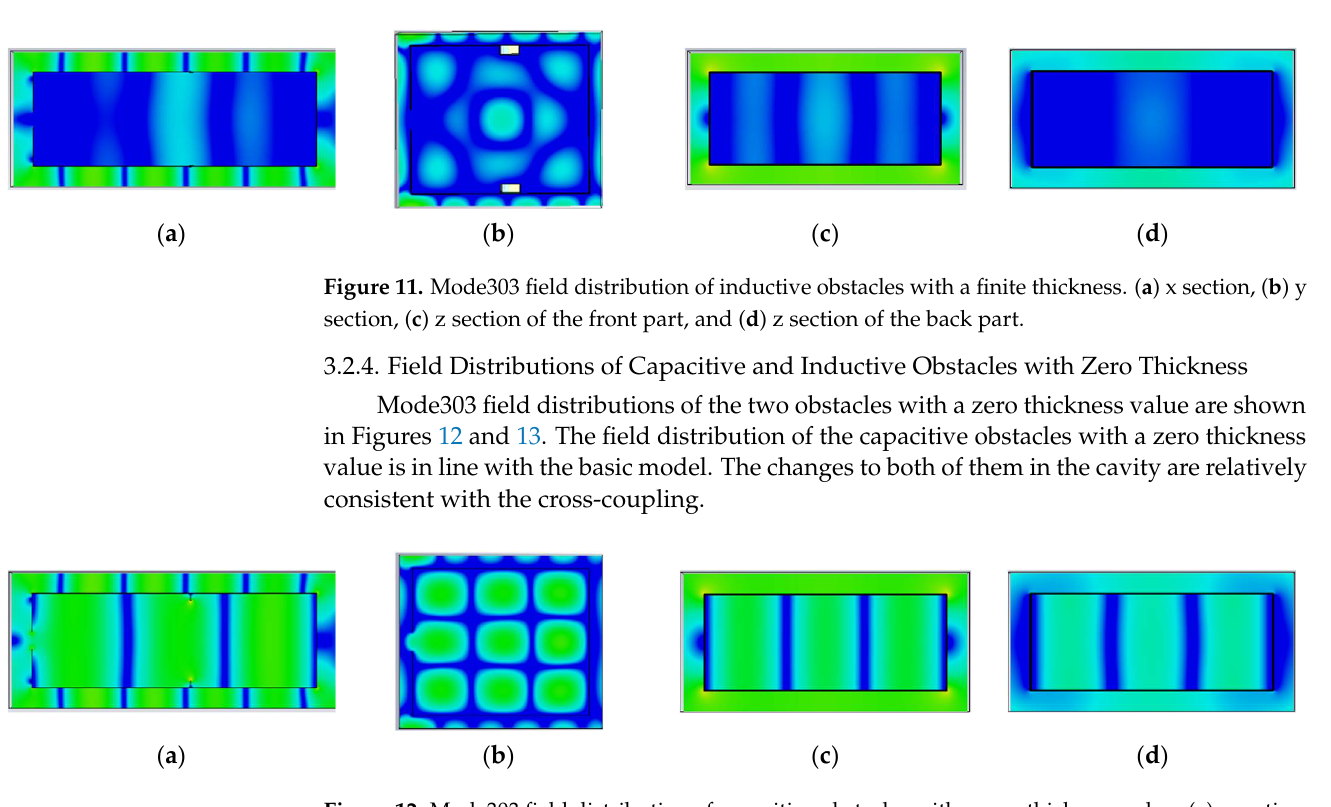
y section, ( c ) z section of the front part, and ( d ) z section of the back part.